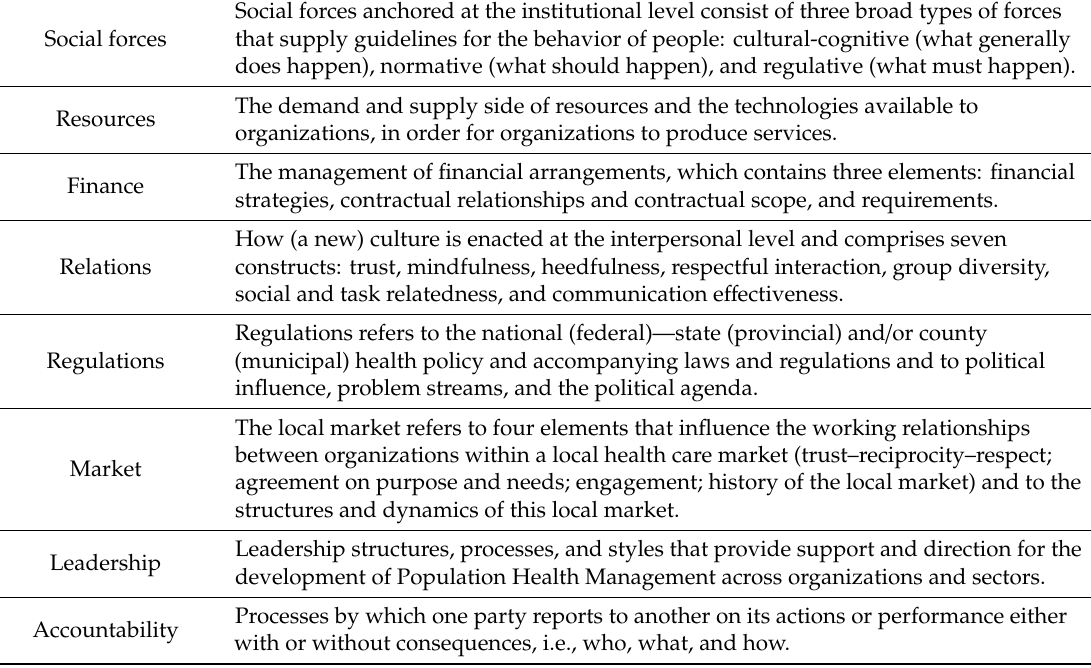
Table 2. Definitions of the eight components of the Collaborative Adaptive Health Networks framework (as described in